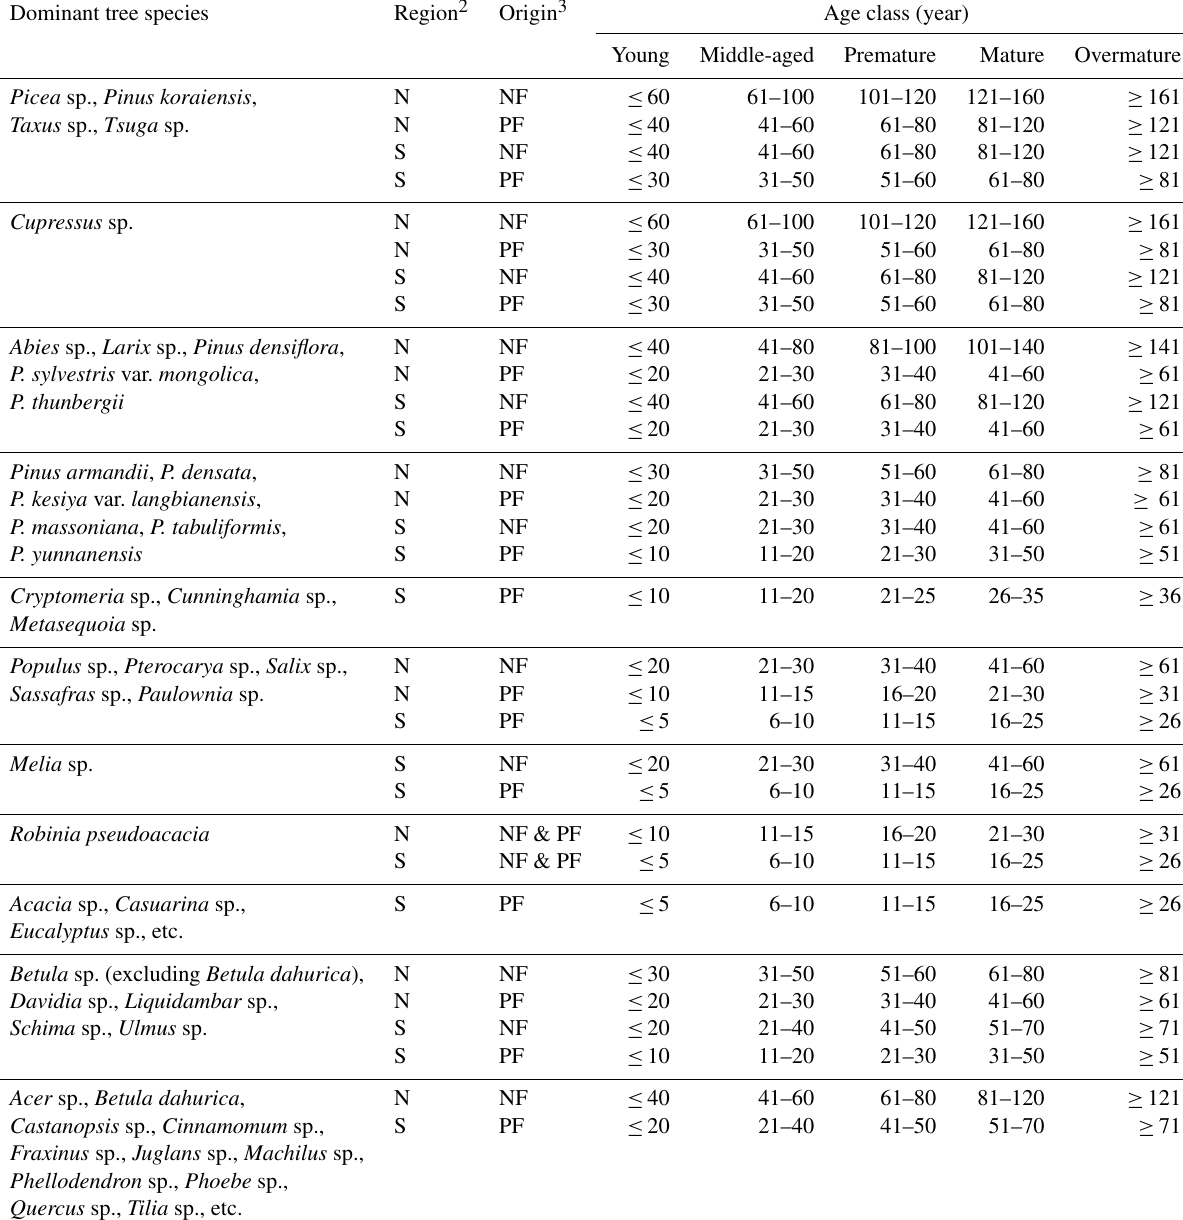
Table A1. Categorization of age class by dominant tree species, growing region and stand origin 1 . Dominant tree